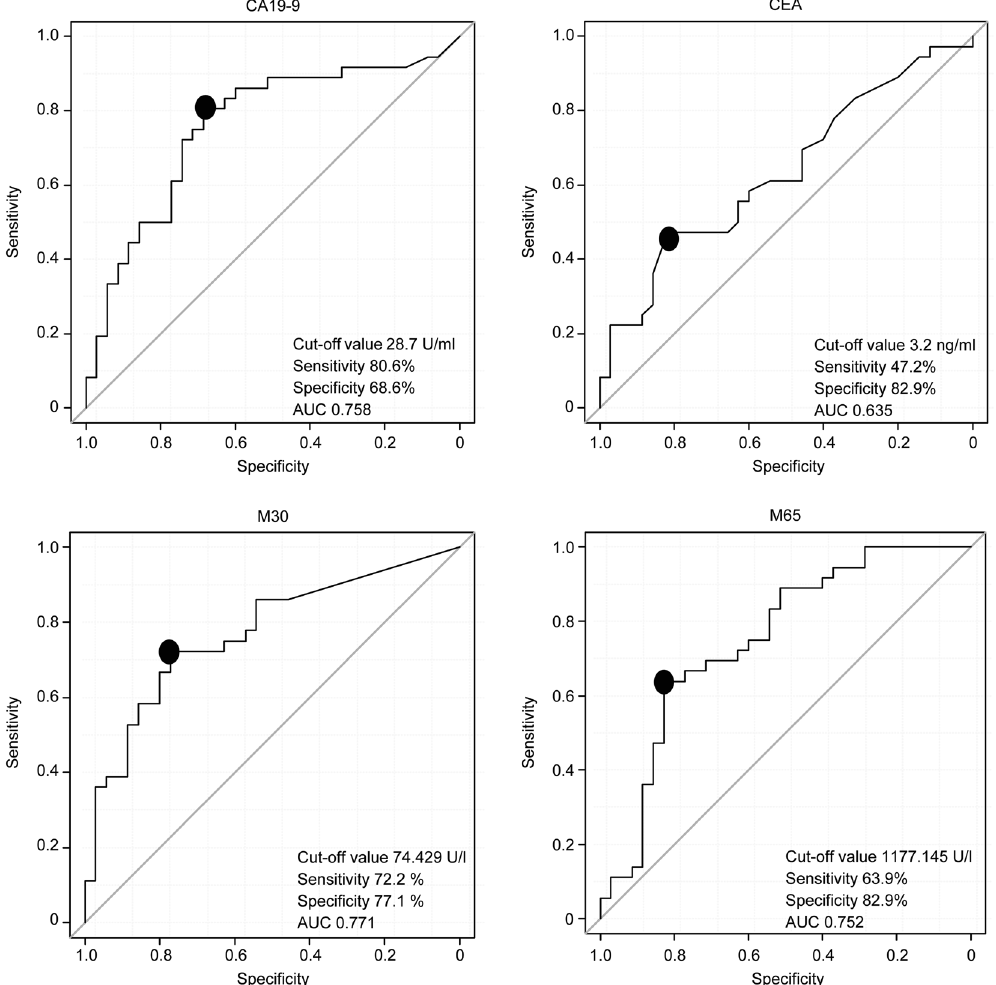
Figure 3. Comparison of four biomarkers for diagnosing biliary tract cancer. AUC , area under the curve. Receiver operating characteristic curves of four markers for 71 patients (36: Malignant group, 35: Benign group). The cut-off values, sensitivity, and specificity of M30 for diagnosing biliary tract cancer were 74.429 U/l, 72.2%, and 77.1%, respectively. The AUC (0.771) of M30 was the highest of the four